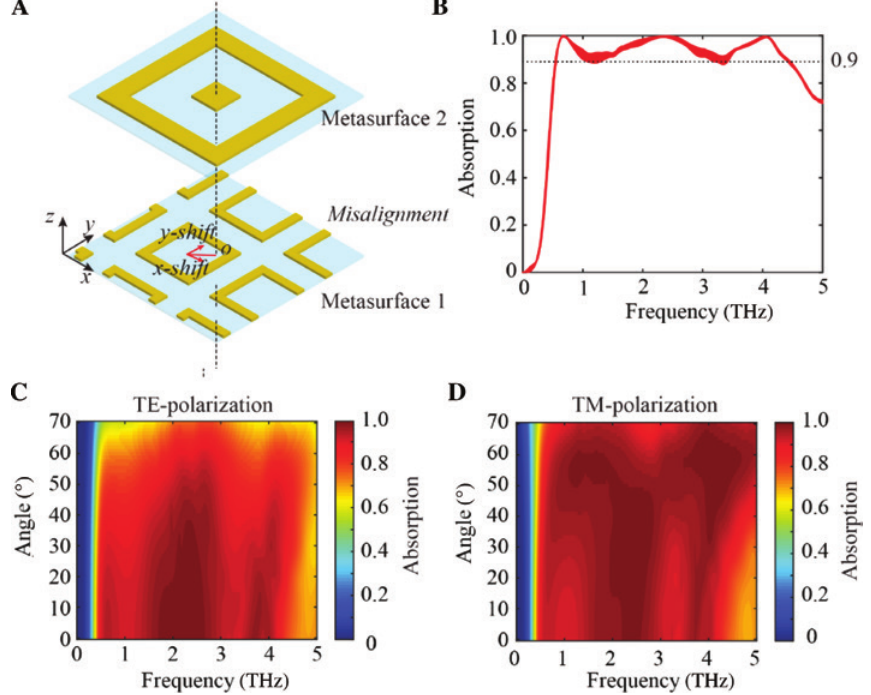
Figure 5: (A) Schematic image of the misalignment between the dual metasurface. (B) Simulated absorption performance when the dual metasurface is misaligned. Simulated absorption of the designed absorber as functions of the incident angle and working frequency for TE (C) and TM (D) polarizations. The normalized absorption is represented by different